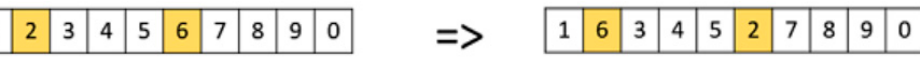
Figure 4. Swap mutation operator.